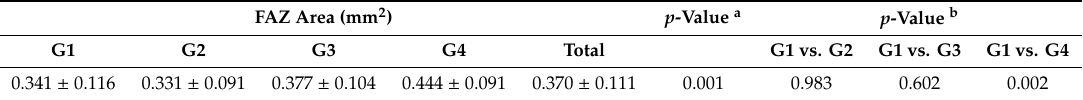
Table 2. Foveal avascular zone (FAZ) area measurements by age group.